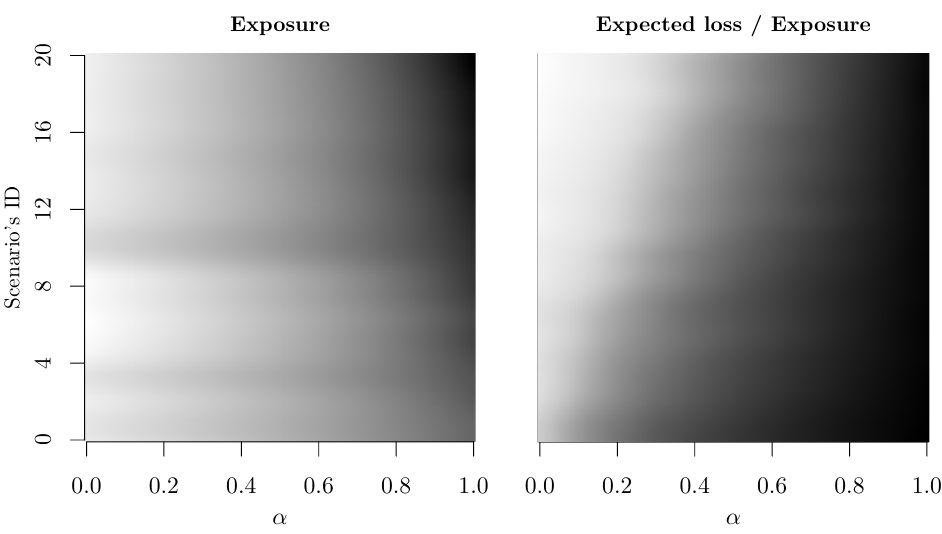
Figure 7. Smooth transition of exposure and loss-to-exposure ratio, passing from s (cid:63) s (cid:63) HR